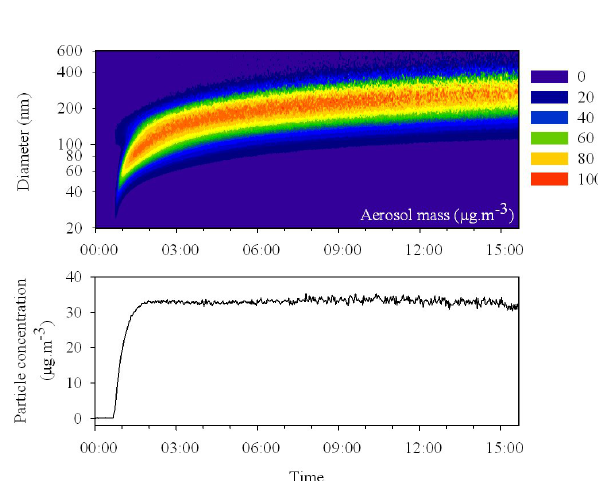
Fig. 13. Aerosol lifetime experiment. Aerosol mass concentration and aerosol size distribution in mass during an aerosol production experiment from the ozonolysis of 100ppb of sabinene. Top panel: aerosol size distribution in mass as measured with SMPS; bottom panel: aerosol mass concentration derived from SMPS measure- ment assuming a density of 1gcm − 3